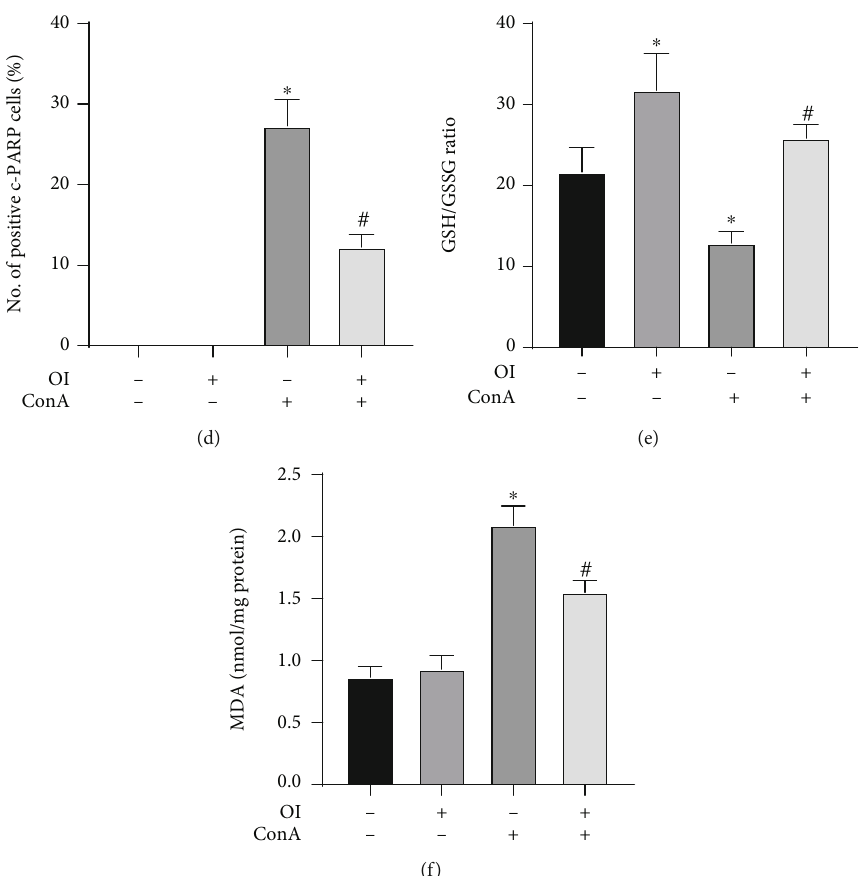
Figure 3: OI decreased Con A-induced hepatocyte apoptosis and oxidative stress in liver. Representative images for (a, b) positive TUNEL cells and immunohistochemical assay of (c, d) c-PARP were evaluated in hepatic tissues in each group. The (e) GSH/GSSG ratio and (f) MDA levels were measured in hepatic tissues in each group. Data are expressed as mean ± SEM ( n = 6 ). ∗ p < 0 : 05 vs. control group. # p < 0 : 05 vs. Con A